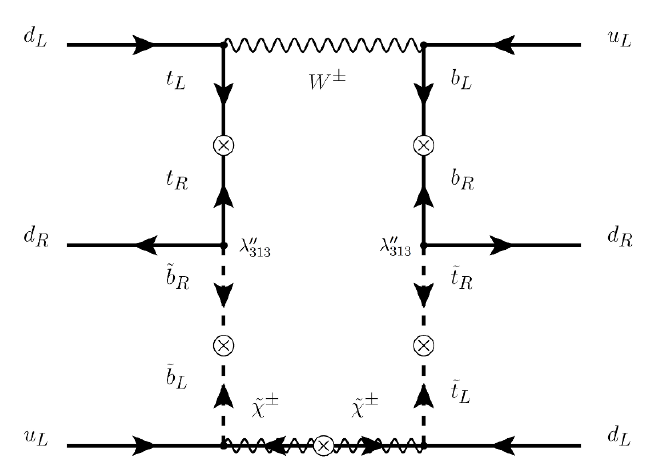
Figure 1 . Electroweak loop diagram inducing n { n oscillation from the (cid:21) 00